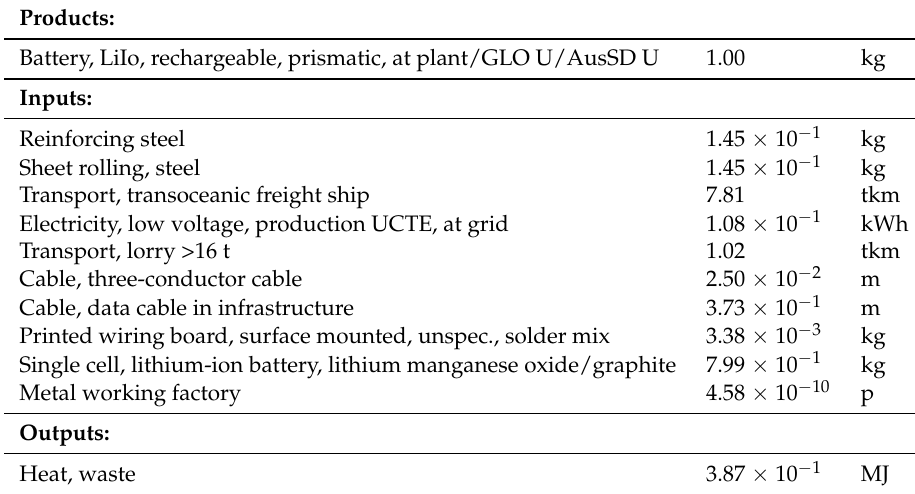
Table 3. life cycle inventory of LiIo battery developed for LCA analysis in this research. Products: